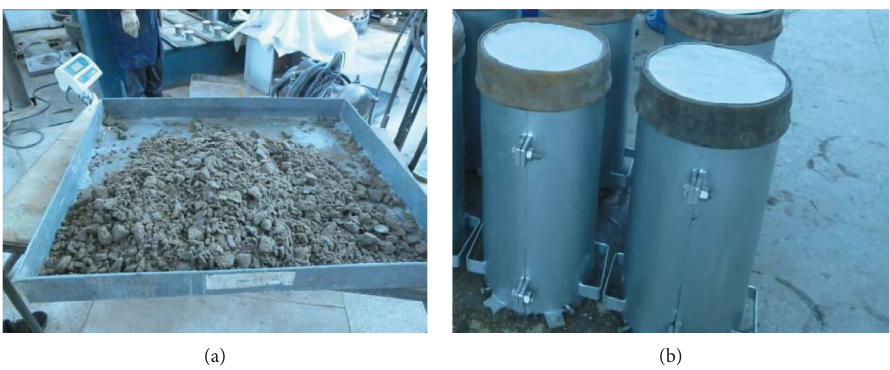
Figure 2: (a) Mixed materials; (b) samples of CSG